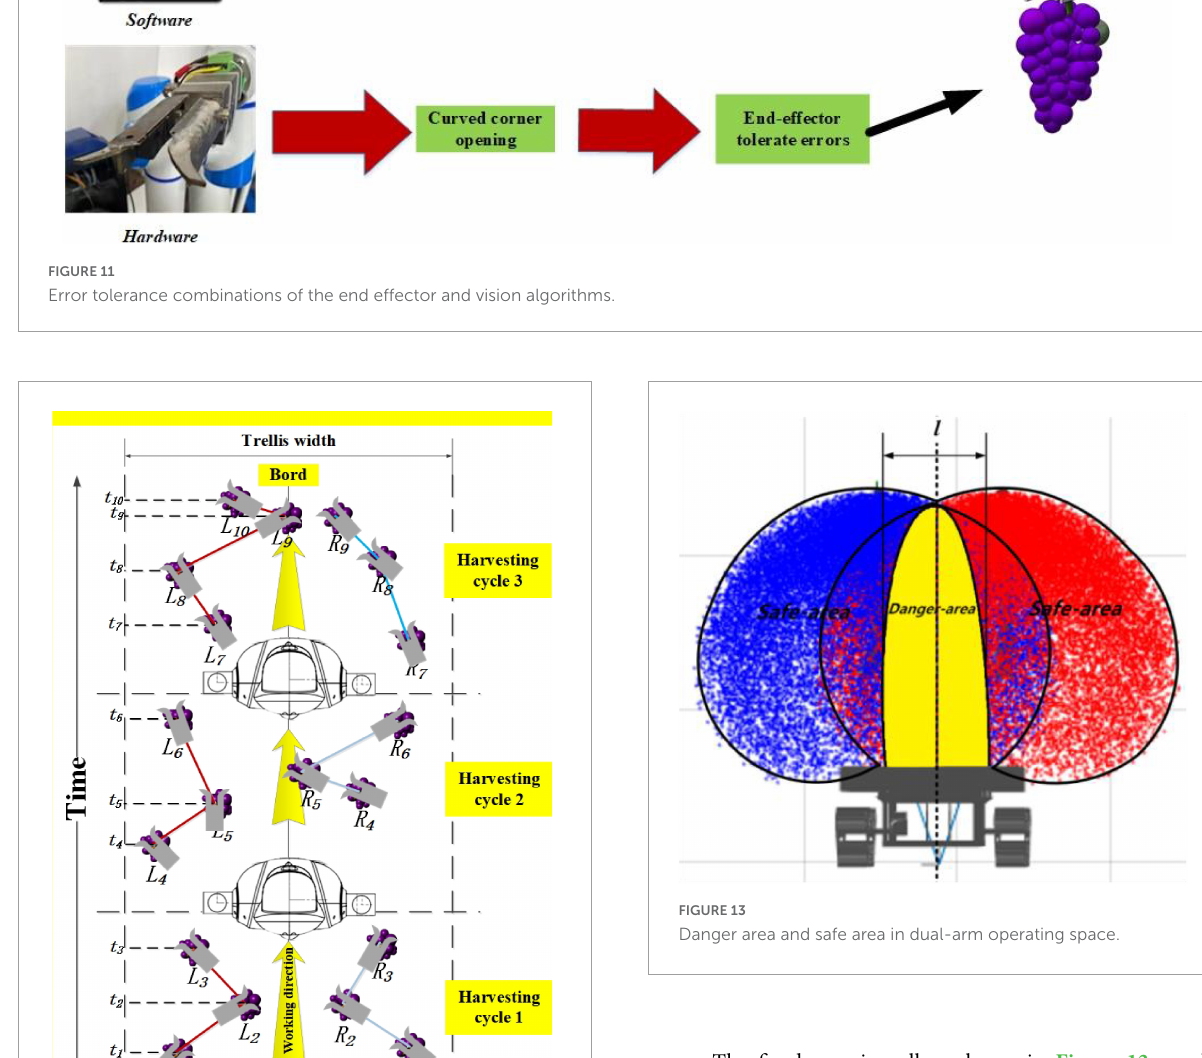
FIGURE12 Dual-arm harvesting sequence in a horizontal trellis.